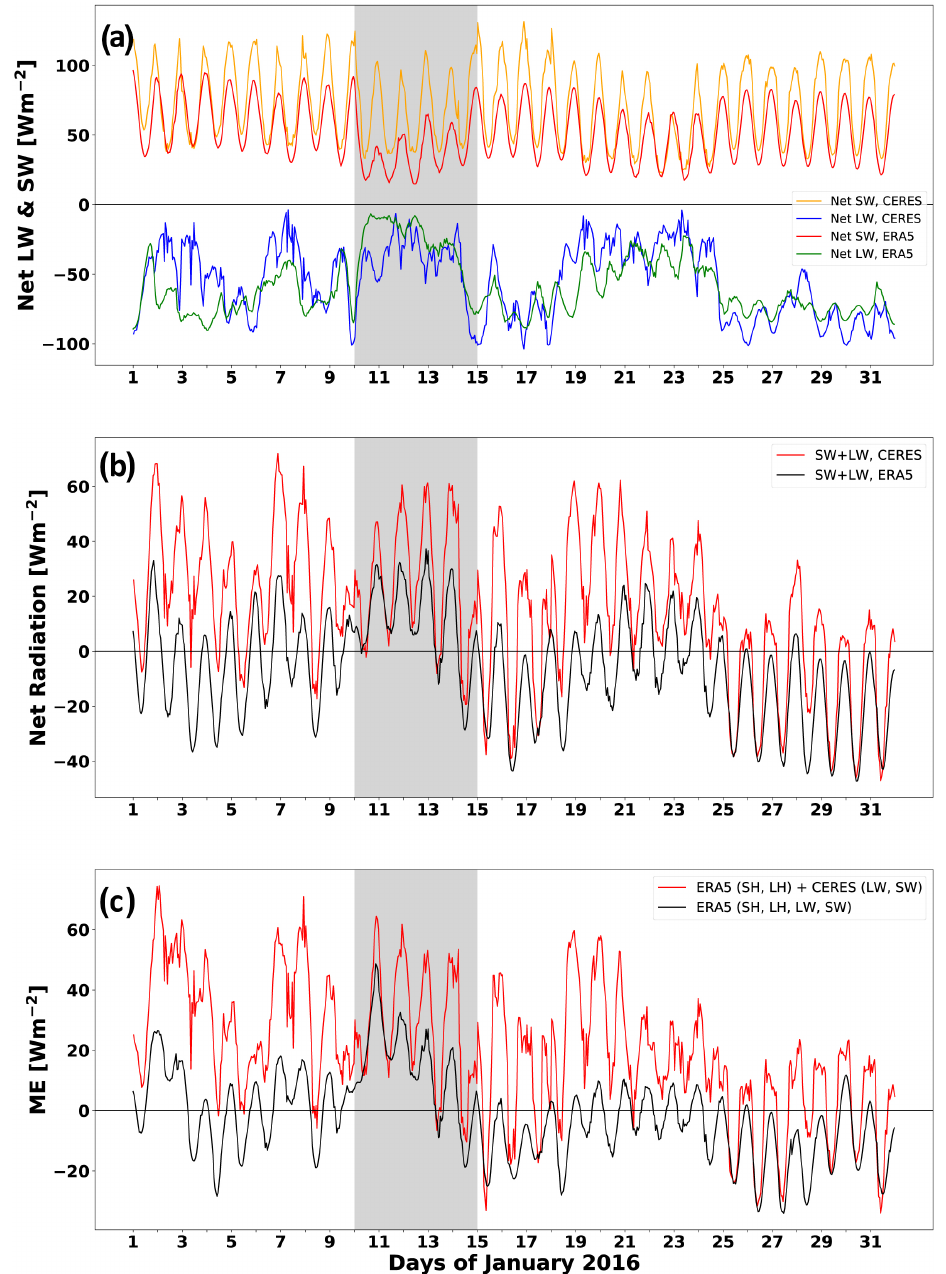
Figure A3. Radiative flux components and alternative estimates of the ME over Siple Dome during January 2016: (a) individual net SW fluxes from ERA5 (red) and CERES SYN1deg data (yellow) and net LW fluxes from ERA5 (green) and CERES SYN1deg data (blue); (b) total net radiative flux from ERA5 (black) and CERES SYN1deg data (red); (c) ME computed entirely from ERA5 (black) and using ERA5 turbulent fluxes but substituting the CERES SYN1deg radiative fluxes (red).